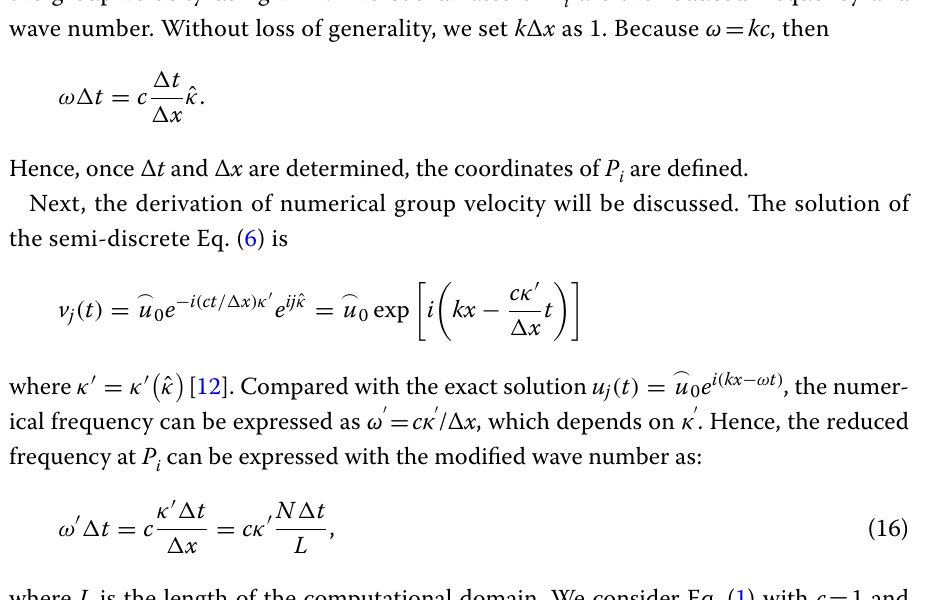
Table 1 Size of computational grid, time step, and coordinates of P Point Grid number N x Time step, Δ t ( k Δ x , ω Δ t )